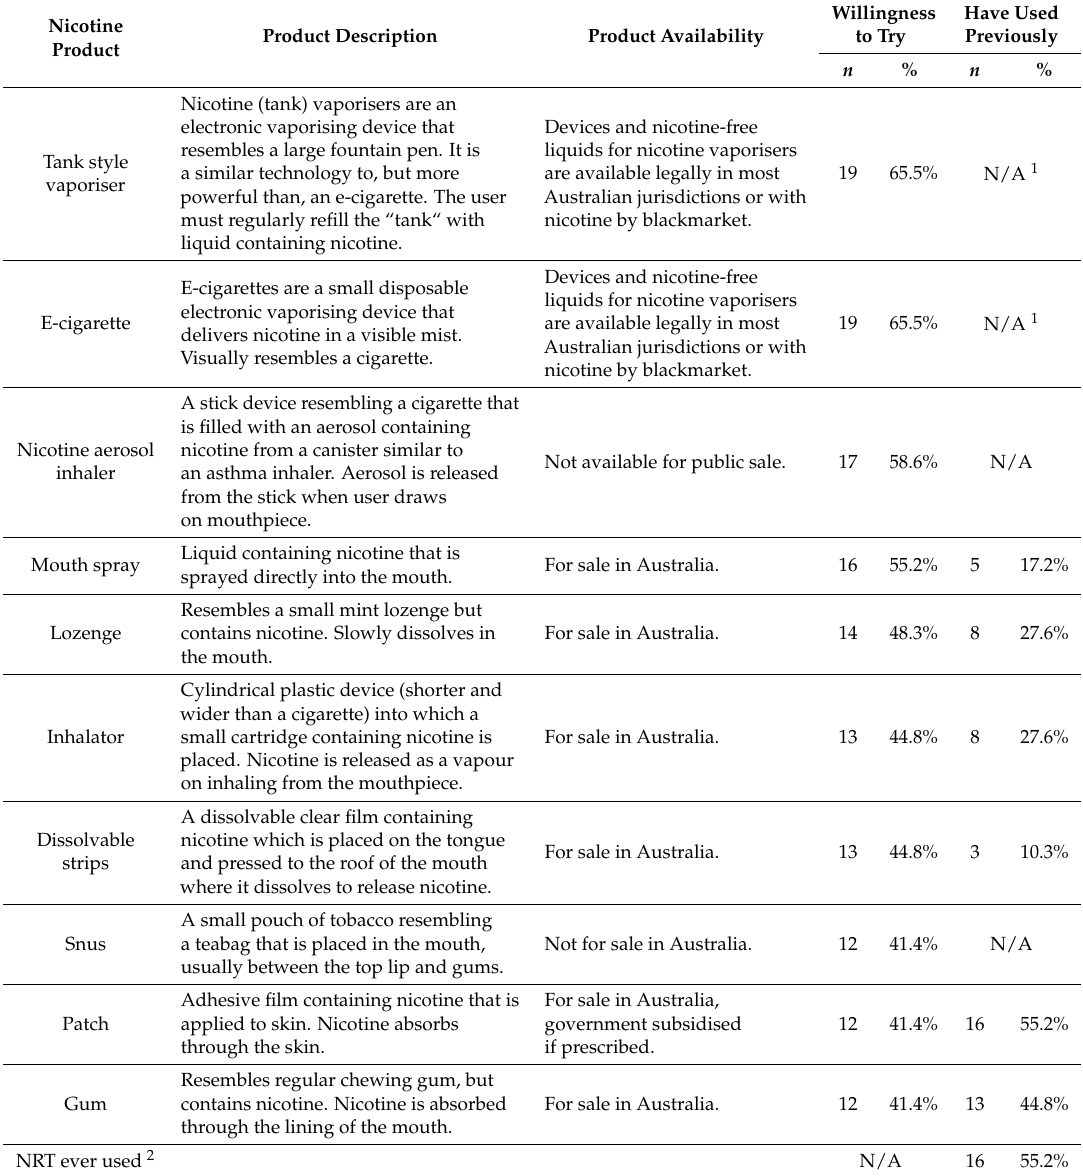
Table 1. Definitions and summary statistics on nicotine product use and willingness to